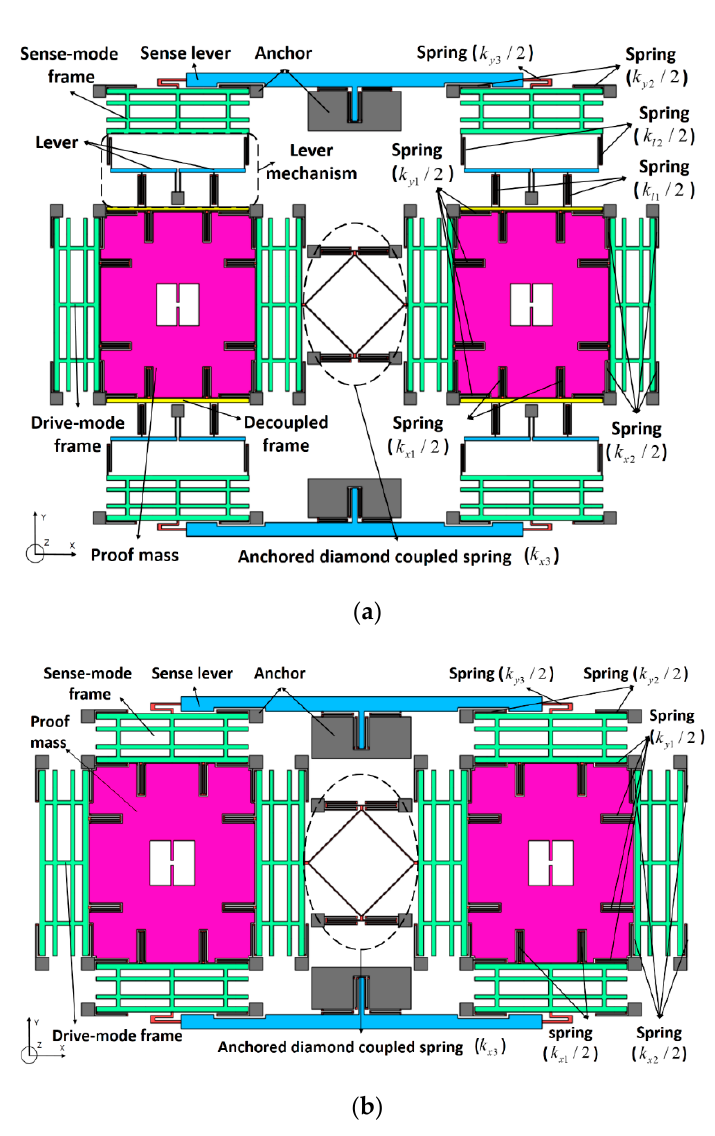
Figure 1. Schematic of designed tuning fork gyroscopes (TFGs): ( a ) type A, ( b ) type B.